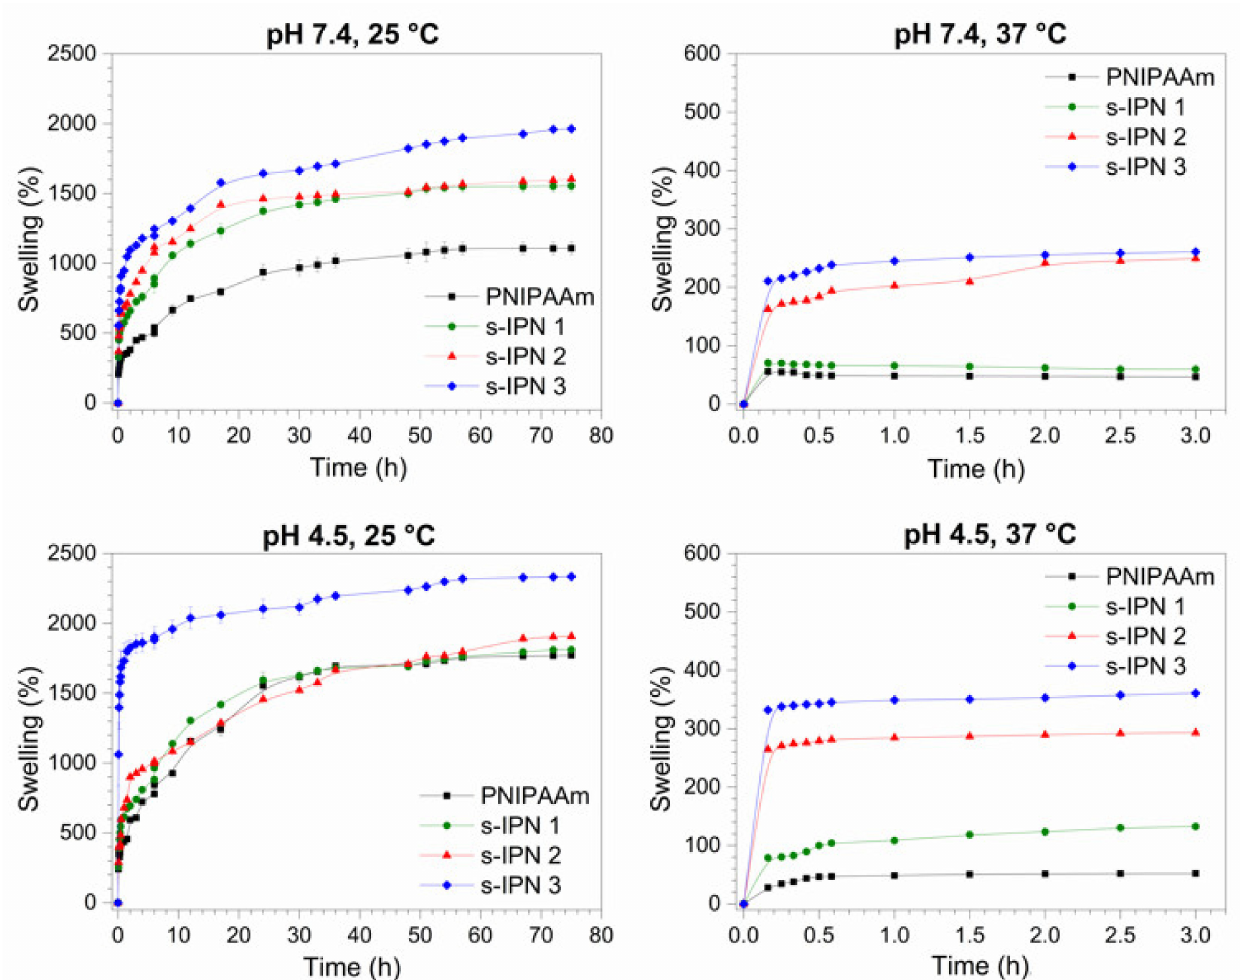
Figure 6. Swelling kinetics of the neat PNIPAAm hydrogel and those of s-IPN samples in buffer media pH 7.4 and pH 4.5, at temperatures of 25 and 37 ◦ C. The experimental points were joined using a spline line